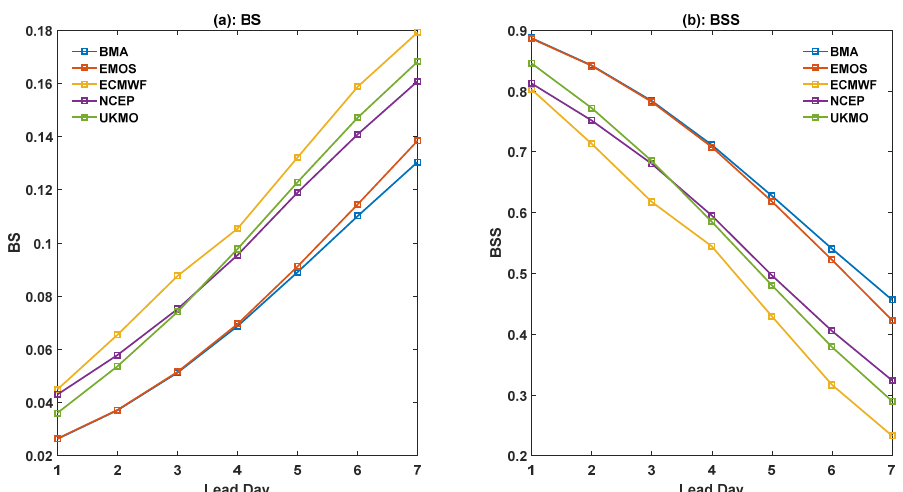
Figure 6. ( a ) Brier score and ( b ) Brier skill score of probabilistic forecasts of the 500 hPa geopotential height higher than the climatology values by the BMA, EMOS, and raw ensemble forecasts with lead times of 1–7 days.